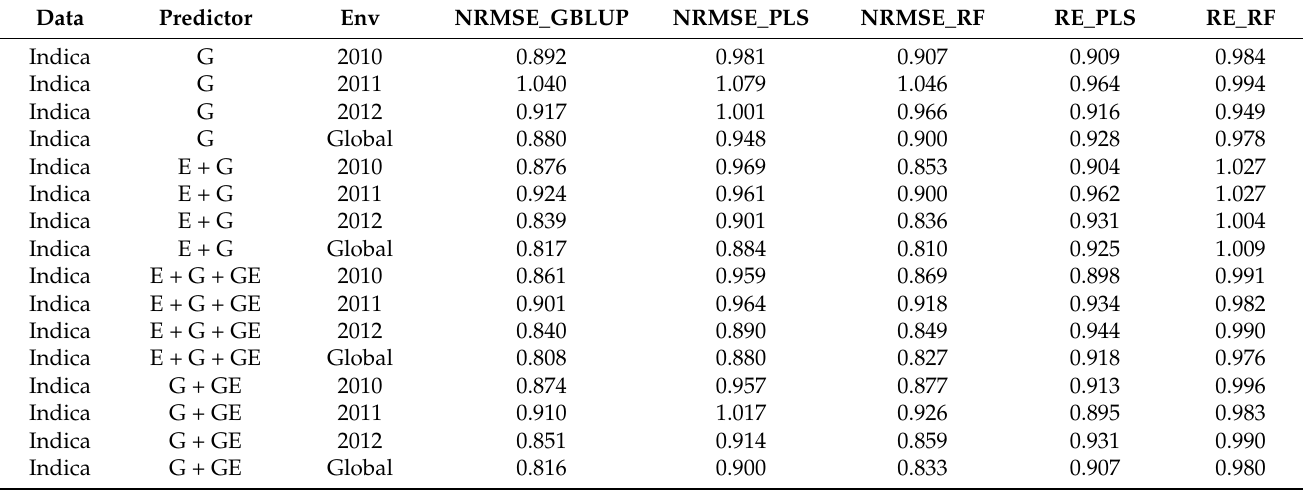
Table 2. Prediction performance for each environment and across environments (Global) of dataset 1 (Indica) in terms of normalized mean square error (NRMSE) and relative efficiency (RE) under four predictors (G, genotypic information; E + G, environment plus genotypic information; E + G + GE, environment plus genotypic plus genotype by environment interaction information; and G + GE, geno- typic plus genotype by environment interaction) under sevenfold cross validation. NRMSE_GBLUP, NRMSE_PLS and NRMSE_RF denote the NRMSE under the GBLUP , PLS and random forest models, respectively. RE_PLS and RE_RF denote the relative efficiency (RE) calculated with the NRMSE of the PLS and random forest models, respectively. RE was calculated by dividing the prediction performance (with NRMSE) of the GBLUP model between the prediction performance of the PLS and random forest models; that is, the GBLUP model was considered the reference